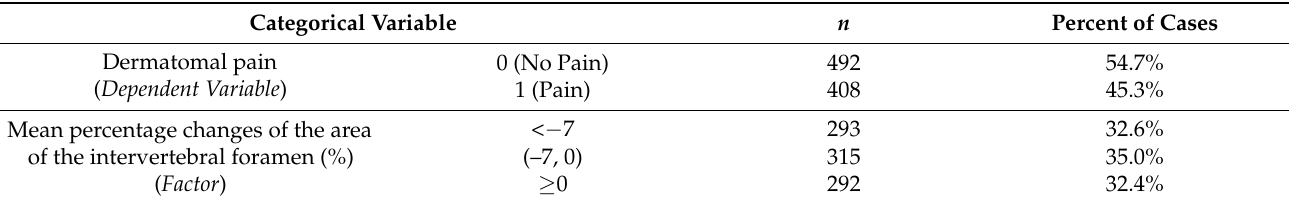
Table 3. Categorical variable